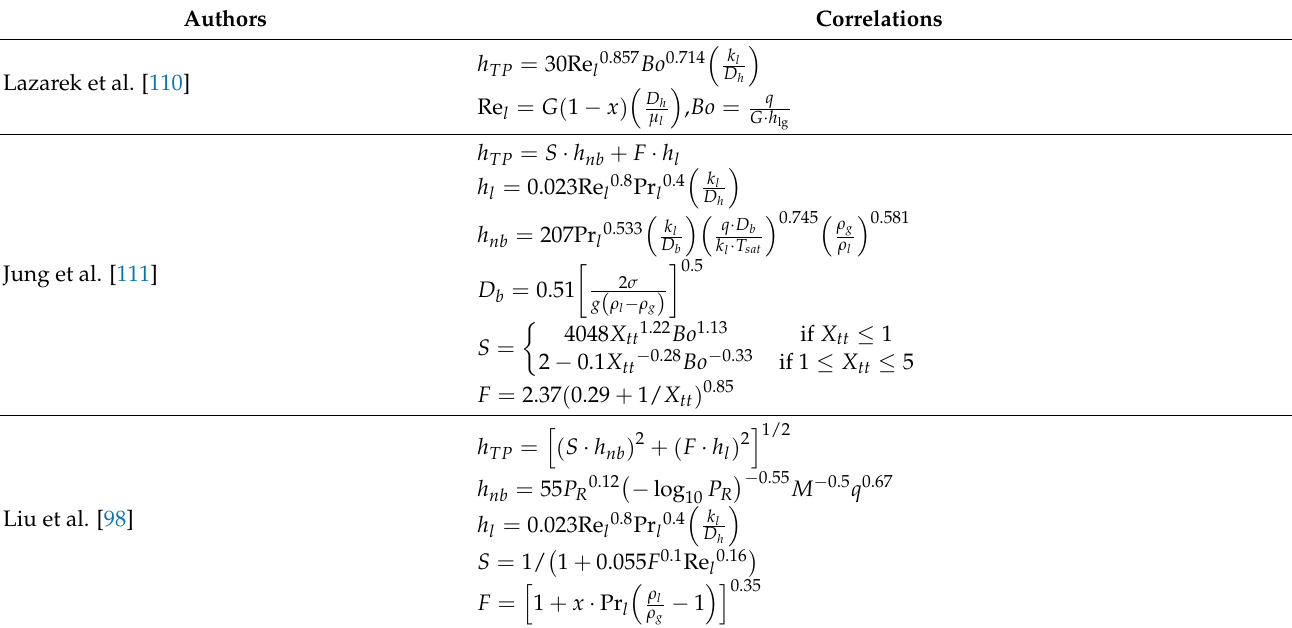
Table 7. Flow boiling models for pure refrigerants to calculate